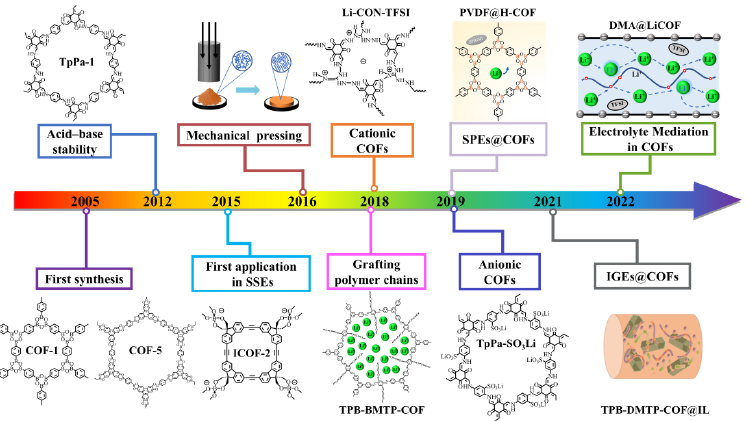
Figure 1. A brief chronology of the development of COFs in SSEs.